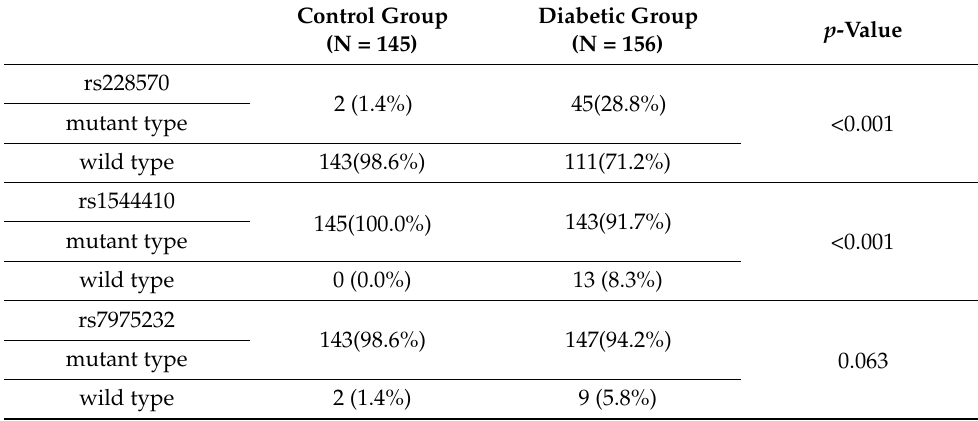
Table 4. Allelic Discrimination of Vitamin D among the Study Groups.